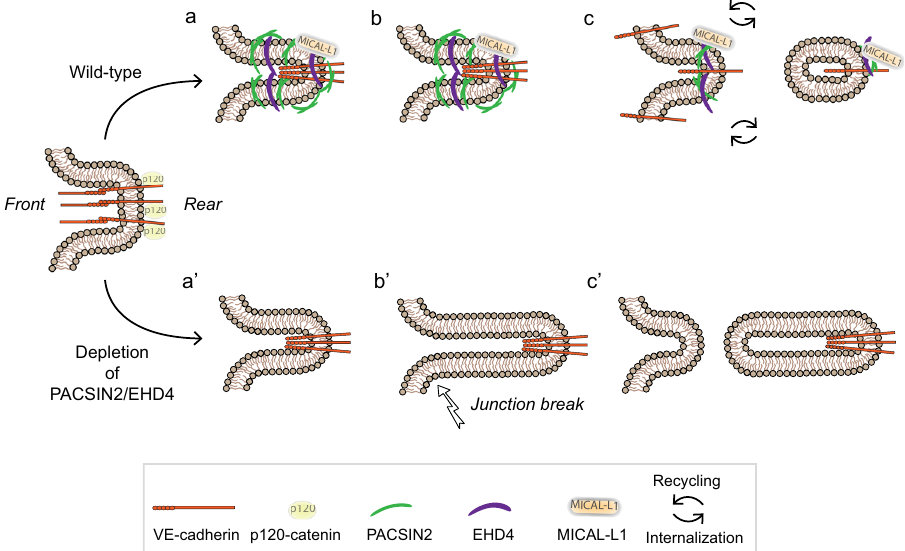
Fig. 7 EHD4 is needed for endothelial directed migration, in vitro angiogenic sprouting and coordination of angiogenesis in vivo. a Representative phase-contrast images of scratch wound assays at 9 h and 40 min post-scratch performed on HUVEC monolayers transduced with shControl, shEHD4-E1, and shEHD4-E10. The punctuated yellow lines indicate the boundaries of the wound. See Supplementary Movie 6 for time-lapse images of the scratch wound migration. b Quanti fi cation of wound-healing velocity measured in surface area per min of post-scratch HUVEC monolayers transduced with shControl ( n = 36 movies), shEHD4-E1 ( n = 24 movies) and shEHD4-E10 ( n = 35 movies) from three independent experiments. P < 0.0001 when comparing shControl to shEHD4-E1 and when comparing shControl to shEHD4-E10. c Quanti fi cation of the correlation length of wound-healing time-lapse recordings of HUVECs transduced with shControl ( n = 19 movies), shEHD4-E1 ( n = 17 movies), and shEHD4-E10 ( n = 19 movies) from four independent experiments using particle image velocimetry (PIV) analysis. P = 0.0384 when comparing shControl to shEHD4-E1 and P = 0.0035 when comparing shControl to shEHD4-E10. d Representative phase-contrast images of sprouting spheroids from HUVECs transduced with shControl, shEHD4-E1, and shEHD4-E10 after 16-h stimulation with VEGF. e Quanti fi cation of the number of sprouts per spheroid and the average sprout length of HUVECs transduced with shControl ( n = 35 spheroids), shEHD4-E1 ( n = 30 spheroids), and shEHD4-E10 ( n = 23 spheroids). Data are from three independent experiments. P < 0.0001 when comparing shControl to shEHD4-E1 and when comparing shControl to shEHD4-E10. f Representative images of whole- mount retinas stained for Isolectin B4 (IB4, red) and ERG (cyan) from control ( Ehd4 + / + ) and Ehd4 − / − mouse littermates at P6. g Quanti fi cation of the number of branch points per unit area (at least seven retinas per genotype from three independent littermates), the number of sprouts and the number of nuclei per 100 µ m of sprouting front border (at least 16 retinas per genotype from at least three independent littermates) in the sprouting front of control and Ehd4 − / − P6 retinas. h Representative images of magni fi ed sprouting front of retinas from control and Ehd4 − / − mice at P6 stained for ERG (cyan) and IB4 (red). Red punctuated lines indicate the sprouting front boundary. The red arrows indicate nuclear clusters in abnormal sprouts. i Quanti fi cation of the average sprout length and the number of endothelial cell clusters at the sprouting front of control and Ehd4 − / − P6 retinas (at least 11 retinas per genotype from at least three independent littermates). P = 0.0268 when comparing the sprout length and P = 0.0290 when comparing the number of endothelial clusters in Ehd4 + / + to Ehd4 − / − retinas. j Representative high-resolution images of the sprouting front from control and Ehd4 − / − retinas stained for VE - cadherin (green), ERG (blue), and IB4 (red). The black dotted squares indicate the ROIs that are magni fi ed in the panels below. k Quanti fi cation of the intensity of cytoplasmic VE-cadherin at the vascular sprouts of control and Ehd4 − / − retinas ( n = 4 retinas per genotype, from two independent littermates). All quanti fi cations represent mean ± SEM (error bars), and statistical analysis was performed by a one-way ANOVA and Dunnett ’ s multiple comparisons test in ( b , c , e ) and two-sided Mann – Whitney test in ( g , i , k ). ns non-signi fi cant; * P < 0.05; ** P < 0.01; *** P < 0.001. Scale bars 100 µ m ( a , f ), 50 µ m ( d ), 40 µ m ( h ), 10 and 5 µ m ( j ). Arb. units arbitrary units. Source data are provided as a Source Data fi le.